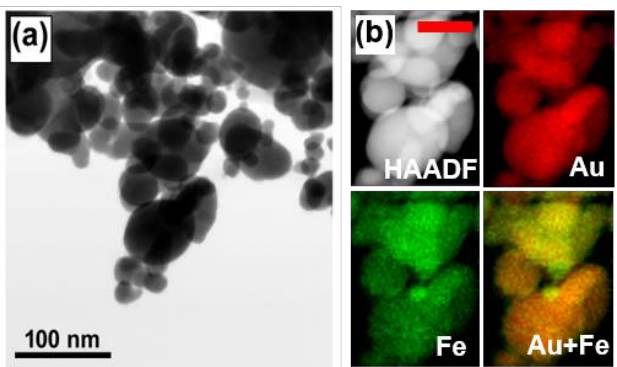
Figure 4. ( a ) A transmission electron microscope (STEM) image annular-dark field (HAADF) image and ( b ) compositional mapping images of the Au-Fe nanoparticles synthesized without templates. The red scale bar in ( b ) corresponds to 50 nm.